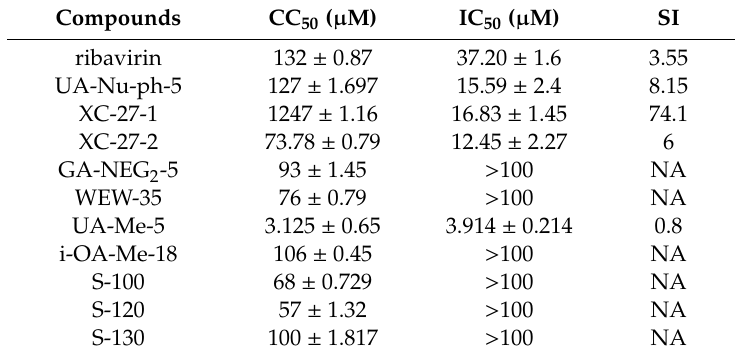
Table 1. Antiviral activities of the tested compounds against H5N1 viruses in MDCK cells (x ± S, n = 3). Compounds